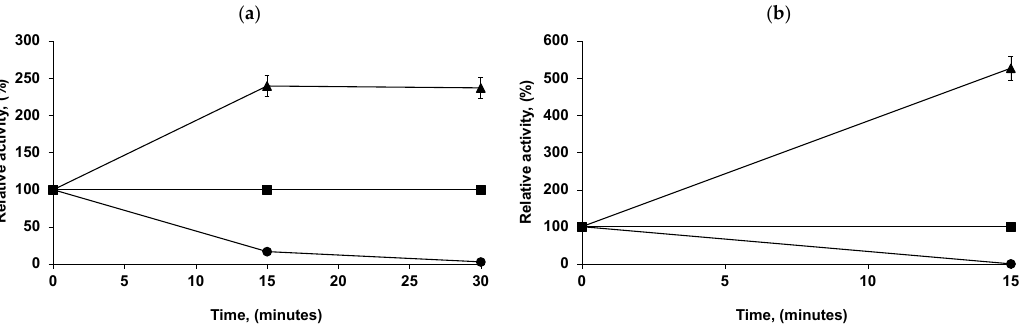
Figure 3. Immobilization courses of different enzymes in octyl-VS-PEI agarose beads. ( a ) LEU and ( b ) RML. Solid squares: reference; solid triangles: suspension and solid circles: supernatant. Other specifications are described in Methods.